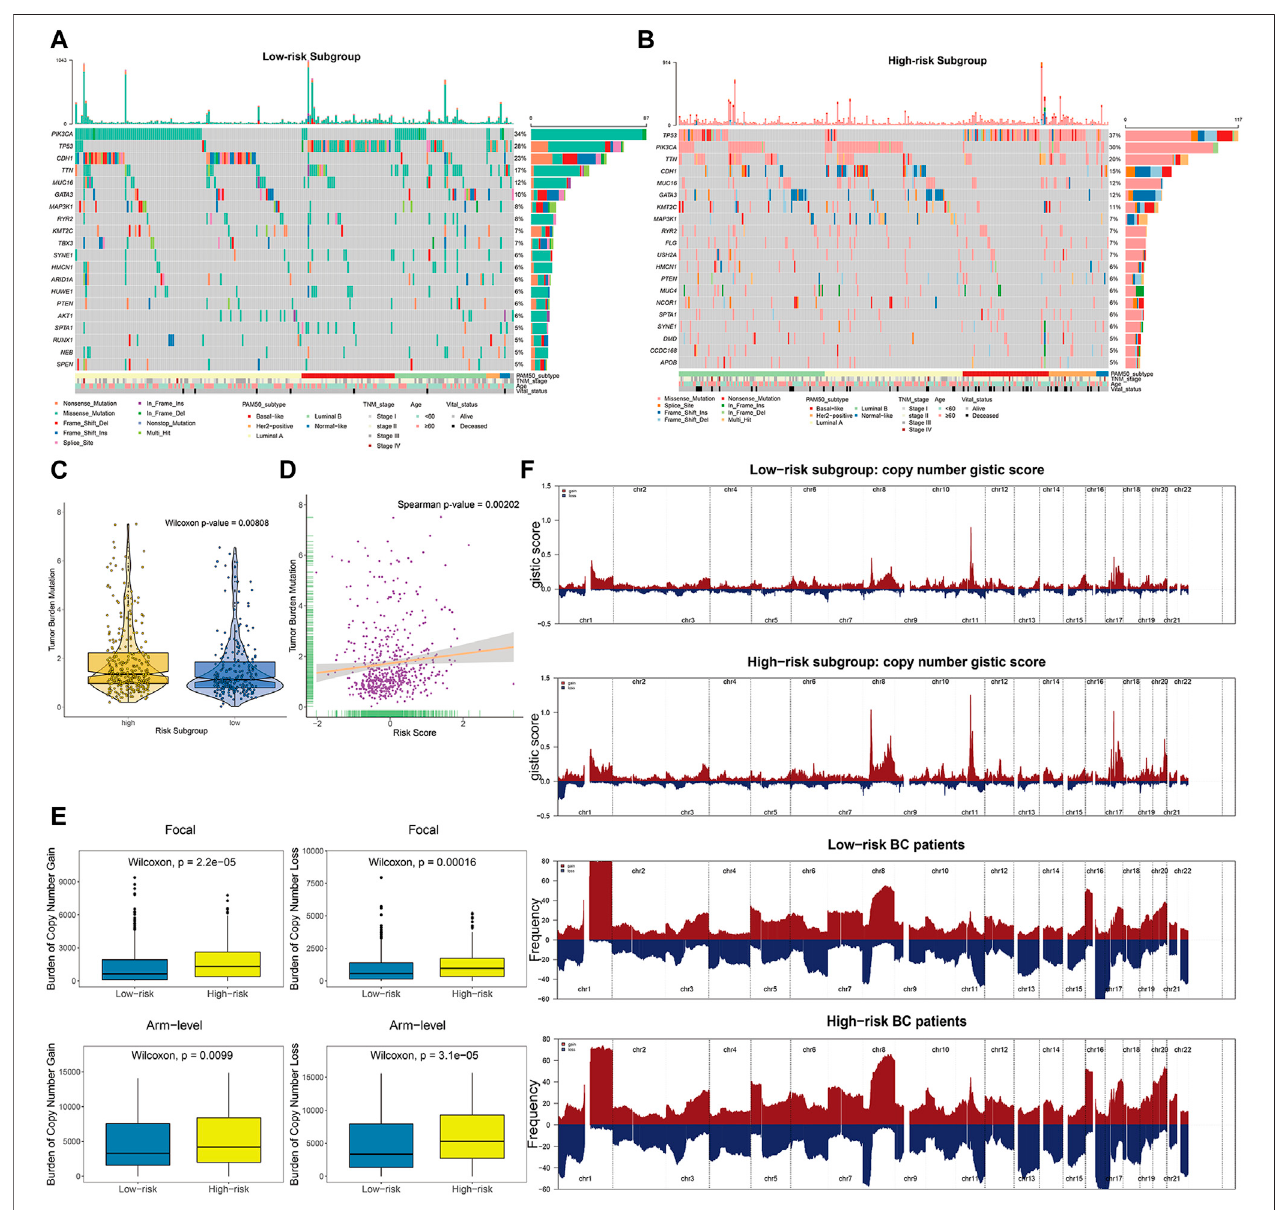
FIGURE 8 | The landscape of mutational signatures and copy number alterations across distinct prognostic subgroups. (A – B) The oncoPrint depicting top 20 signi fi cantly mutated genes in the BC subsets strati fi ed by risk scores, with corresponding clinicopathological characteristics of each subgroup annotated asbelow. (C) TMB difference in the high-risk and low-risk subgroups. Wilcoxon test, p (cid:1) 0.00808. (D) Scatter plot depicting the positive correlation between TMB and risk scores in TCGA BC cohort. Spearman correlation between risk scores and mutation load is shown ( p (cid:1) 0.00202). (E) High-risk BC patients divided by risk scores showed signi fi cantly higher burden of gains and losses, both focal (upper panels) and arm levels (lower panels). (F) Composite copy number pro fi les (gistic scores or altered frequency) for low-risk and high-risk patients, with gains in dark red and losses shown in midnight blue. The copy number segments are placed according to corresponding chromosomal